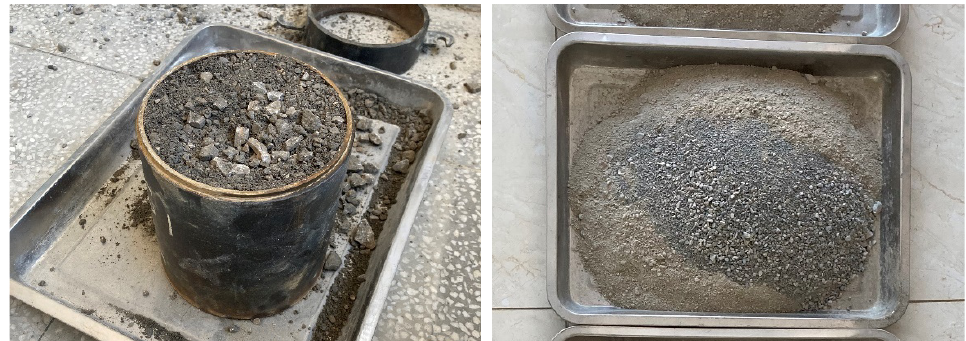
Figure 4. Graded crushed stone samples after repeated compaction and screening.